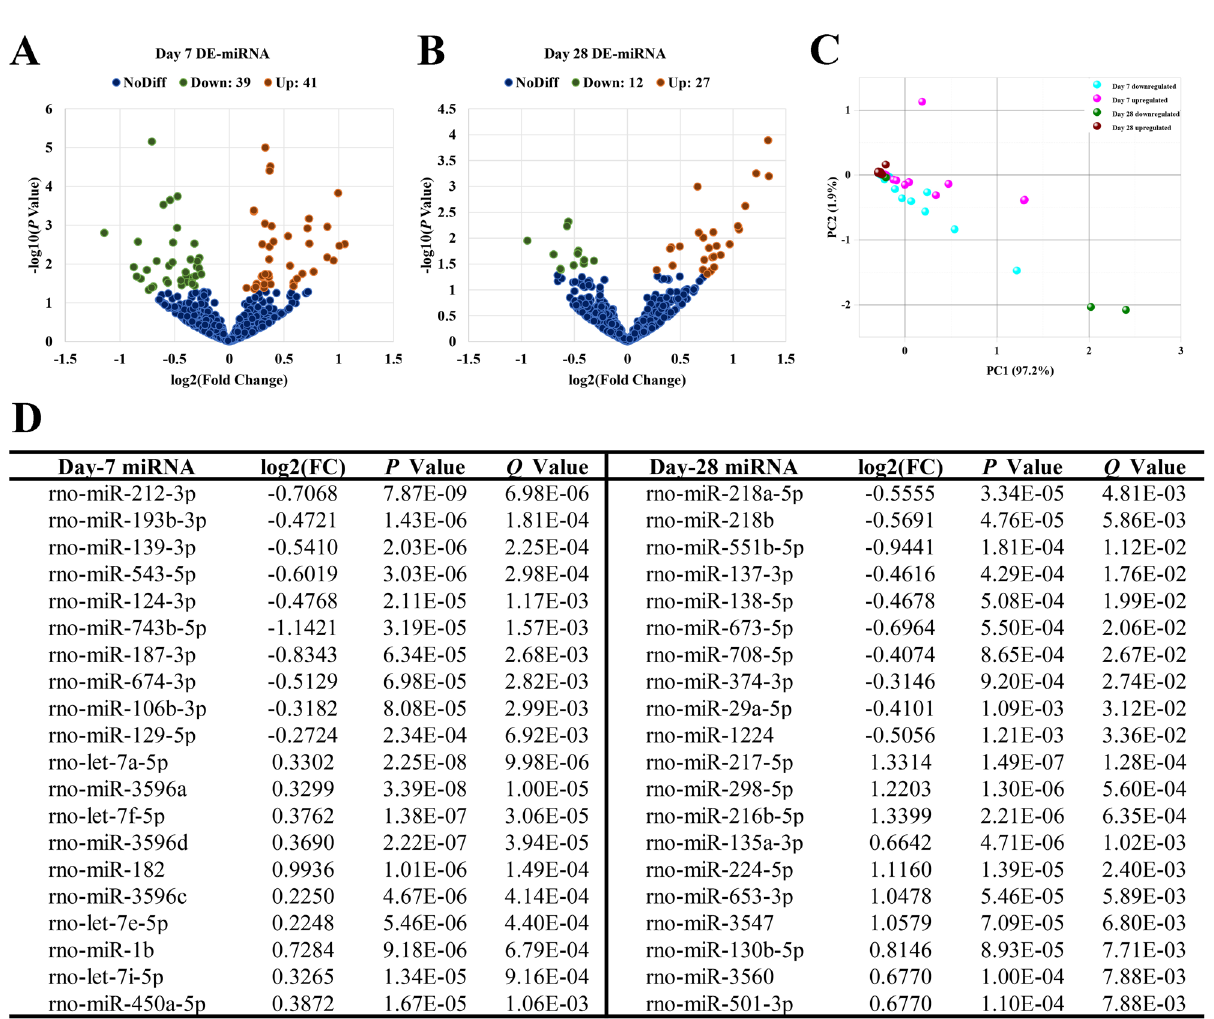
lular pathway. Unsupervised hierarchical clustering of the expression profiles of cerebral differentially expressed